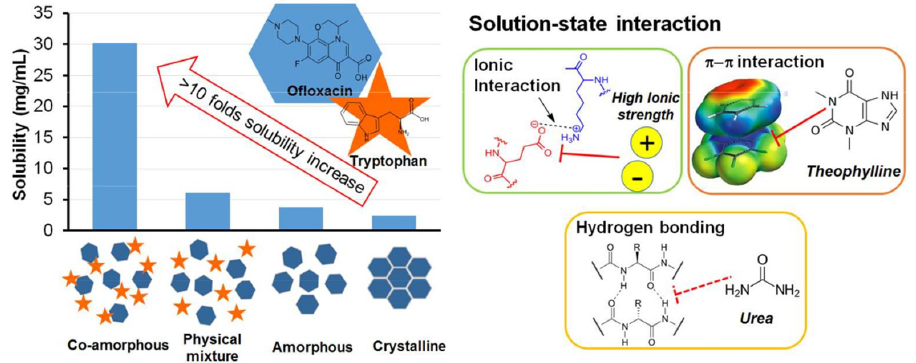
Figure 4. Increased solubility of the co-amorphous systems due to intermolecular interactions [22].